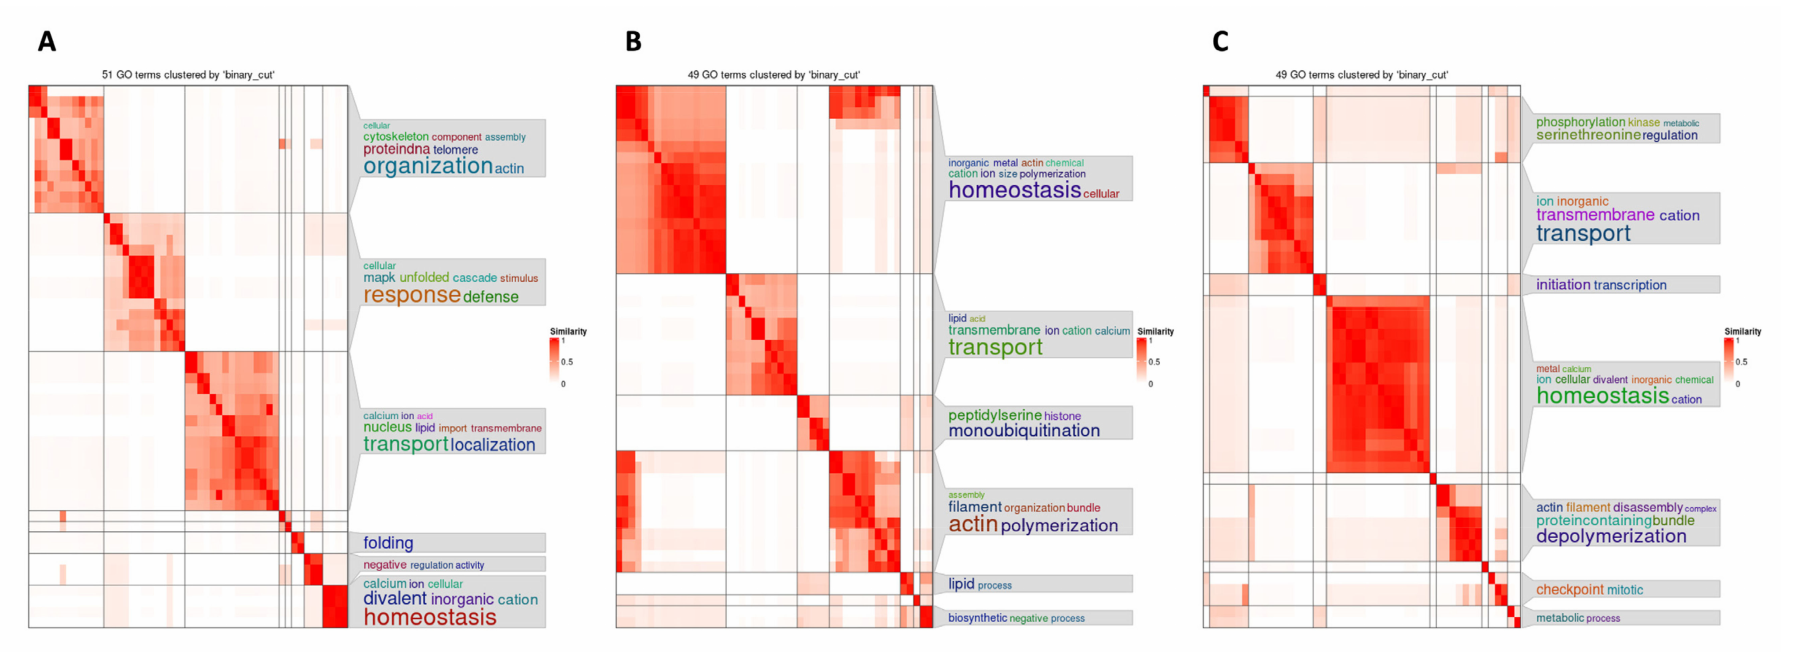
Figure 4. Vitrification affects the pathways involved in oocyte development in vitrified immature (VIM) and metaphase II (VMAT) oocytes, compared to fresh oocytes (FR). This figure represents the SimplifyEnrichment analysis of the resulting GO terms that were clustered by binary cut, enriched, and categorized in biological process for ( A ) VIM vs. FR, ( B ) VMAT vs. FR, and ( C ) VIM vs. VMAT. The enrichment analyses for the cellular components and molecular functions are represented in Supplementary Figures S1 and S2,